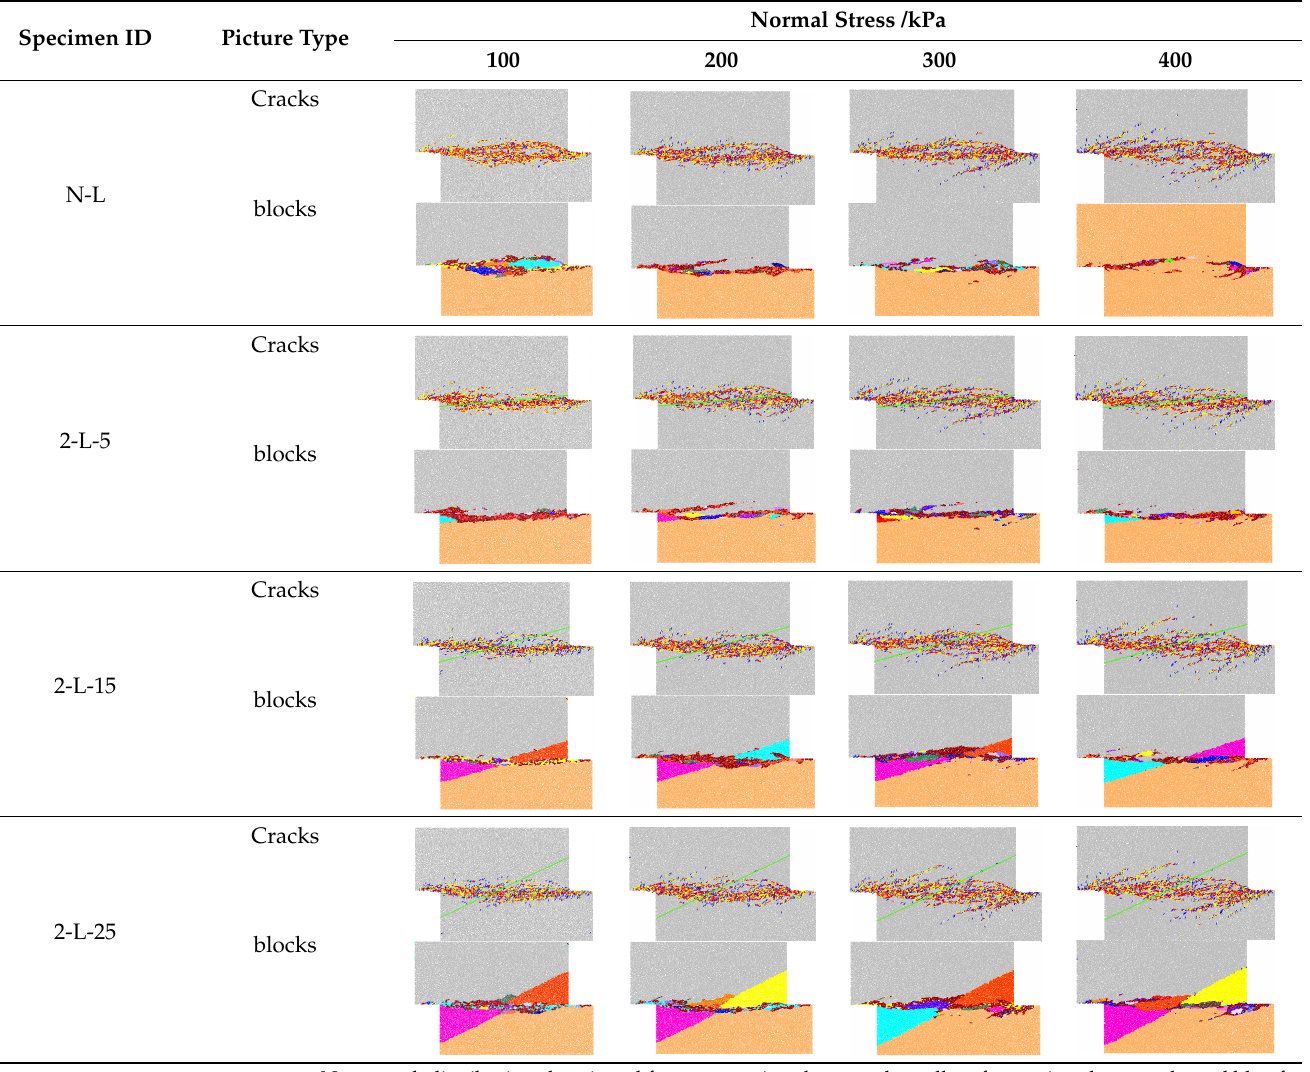
Note: crack distribution chart in red for compression shear cracks, yellow for tension shear cracks and blue for tensile cracks. In the block distribution diagram, particles of the same color together